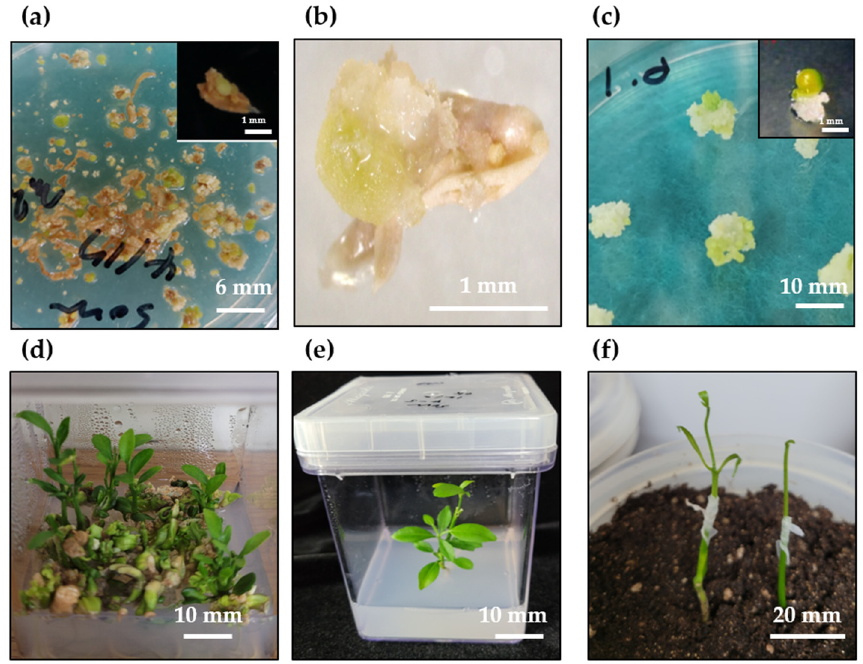
Figure 1. Plant regeneration from anther culture of Citrus aurantium L. (sour orange). ( a ) Callus and embryo induction on N6 liquid medium supplemented with GA 3 (1 mg·L − 1 ) and spermidine; ( b ) formation of callus and direct somatic embryo caused by bursting anther; ( c ) proliferation of induced callus cells and induction of somatic embryo; ( d ) plant regeneration; ( e ) in vitro grafting; ( f ) in vivo grafting.